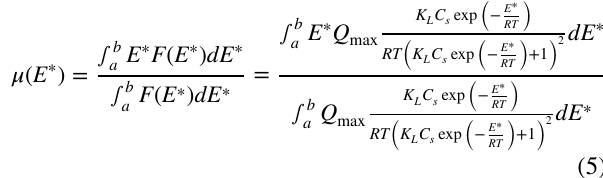
Table 4 Sorption kinetic parameters of Cd 2+ to fresh and aged sludge-derived hydrochars